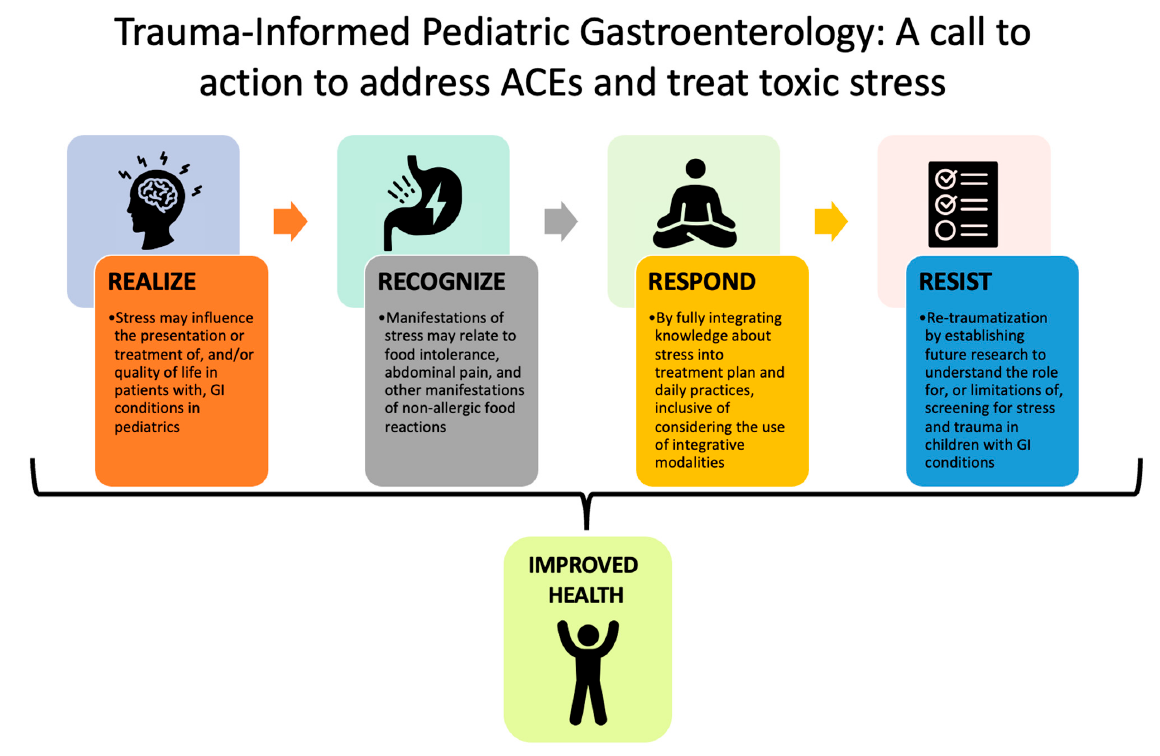
Figure 5. Trauma-Informed Pediatric Gastroenterology: A call to action to address ACEs and treat toxic stress.